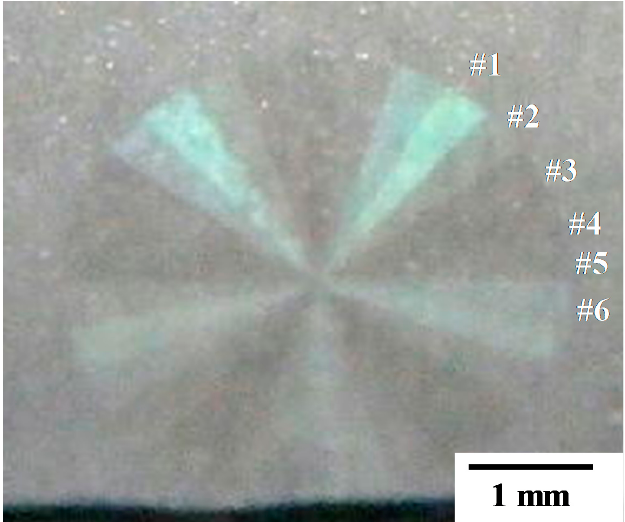
Figure 8. Optical microscopic image on the microtexture of M6, coined onto the surface AA1060 plate. The coined segments are aligned in the clockwise numbering in the mirror-image reversal to the original anti-clockwise alignment in Figure 5.